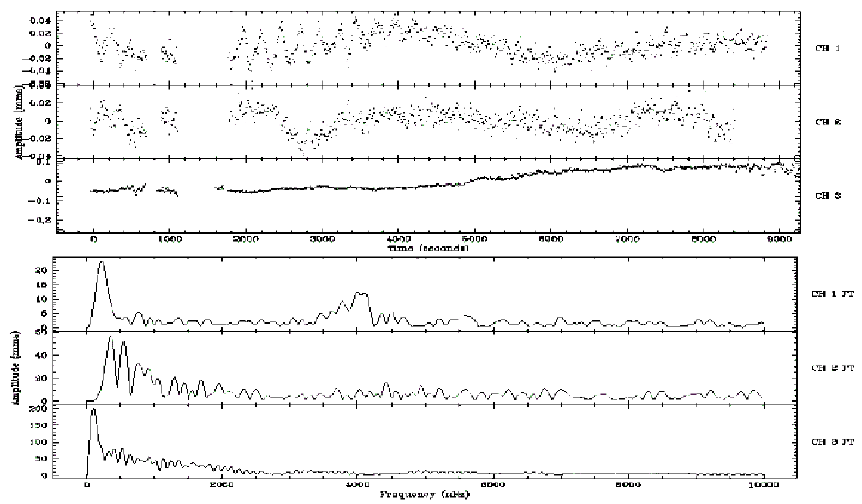
Fig. 3. Light curve of KPD 1930+2752. Lower pannel: the Fourier